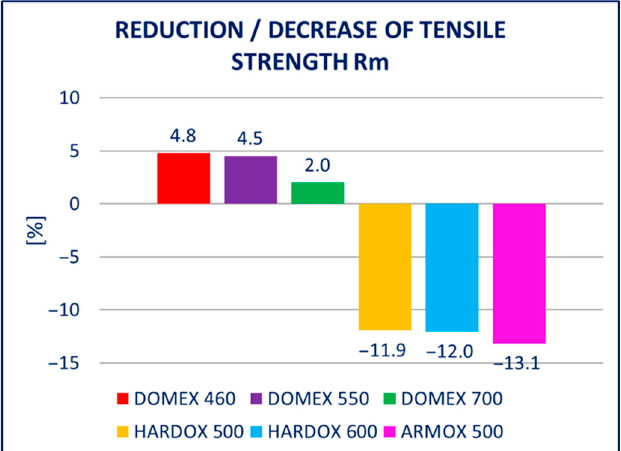
Figure 18. Summary of the results for tensile strength tests presented in the Results section: relative change in R m for the different types of steel.